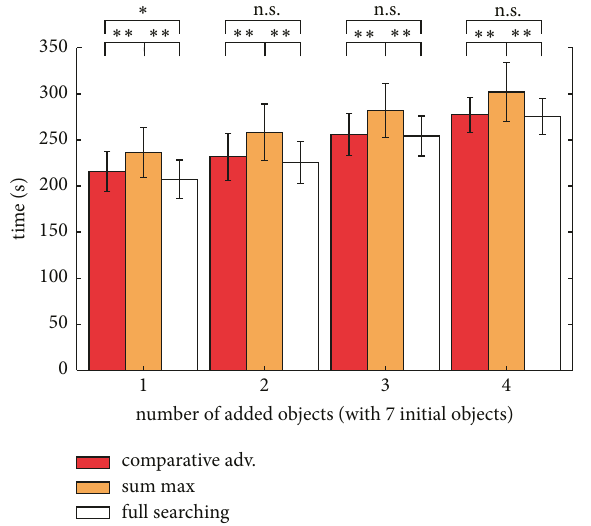
Figure 24: Makespan in situations where carrying objects are added later (three robots). ∗∗ 𝑝 < .01 , ∗ 𝑝 < .05 , and + 𝑝 < .1 . A significant 𝑝 value indicates that a significant difference in prescribing exists between the conditions. The lower 𝑝 value indicates a strong significant difference. n.s. means no significant difference between the conditions.